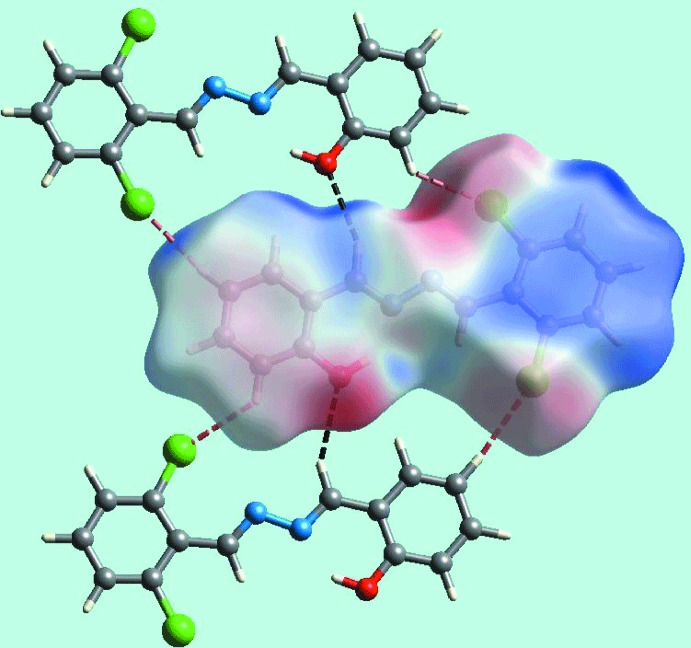
A view of the Hirshfeld surface mapped over the electrostatic potential (the red and blue regions represent negative and positive electrostatic potentials, respectively) in the range −0.065 to + 0.039 atomic units, with short inter­atomic Cl⋯H and O⋯H contacts highlighted with red and black dashed dashed lines, respectively.